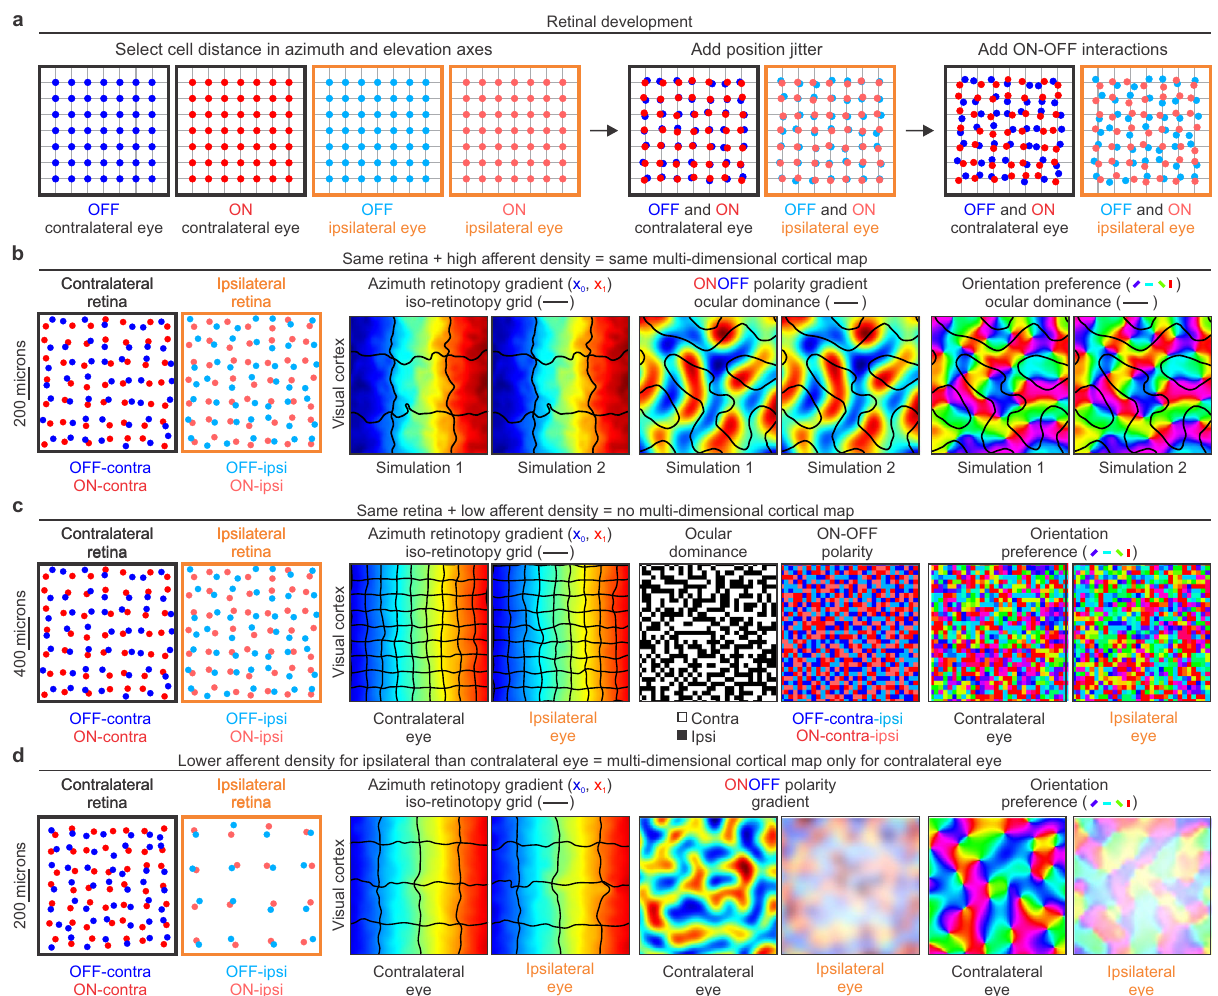
Fig. 3 First model stage: retinal development. a Mosaics of ON and OFF retinal ganglion cells from two eyes generated by the model. The model places cells of each type in a grid (left), then randomly jitters their retinal positions (middle), and applies cell interactions that prevent ON and OFF cells from occupying the same position in each eye. b If afferent sampling density is high, identical ONOFF retinal mosaics generate identical visual cortical maps as shown by two simulations (1 and 2) illustrated in each pair of panels. From left to right, simulated retinas for the two eyes and repeated simulated maps for retinotopy, ONOFF, and orientation preference of stimuli presented in the contralateral eye. The colors illustrate cortical gradients of azimuth retinotopy, ONOFF dominance and orientation preference. The black lines illustrate borders of iso-retinotopic cortical patches in the retinotopic map (regions containing cortical cells with overlapping receptive fi elds), and the ocular dominance borders in the ONOFF and orientation maps. c The same ONOFF retinal mosaics used in the simulations above ( b ) do not generate orientation maps if the spacing of retinal cells is increased to make the afferent sampling density lower (notice different retinal scale in b and c , 200 versus 400 microns). From left to right, each pair of panels show the two retinas, retinotopic maps for contralateral and ipsilateral eyes, afferents in the cortical subplate, and orientation maps. Notice that the size of the iso-retinotopic patch is smaller in ( c ) than ( b ) because the afferent sampling density is also lower. d If the afferent sampling density is lower for the ipsilateral than the contralateral eye, orientation maps emerge from afferent sorting only for the contralateral eye. From left to right, each pair of panels show the two retinas, retinotopic maps, ONOFF maps and orientation maps for the two eyes. Notice that the size of the iso-retinotopic patch is large for both eyes because there is a large number of afferents from the contralateral eye. The afferents from the ipsilateral eye are fewer in number and should have larger axon arbors because they have less synaptic Gaussians function (afferent sorting fi lter) with a cortical subplate with the same eye input and retinotopy (Fig. 4b) and, during the made of random binary values. The afferent sorting fi lter provides ONOFF sorting, they move to regions with the same retinotopy, a simple approach to adjust the shape and size of the afferent eye input and ON-OFF polarity (Fig. 4c, left). This simple clusters and iso-retinotopic domains based on visual sampling 29 algorithm is very effective at sorting afferents by type (Fig. 4c, (see Supplementary Fig 2). However, the model can use any other left). Moreover, because the sorted afferents have similar sorting fi lter that segregates afferents by retinotopy, eye input and retinotopy, the retinotopic map is preserved (Fig. 4c, right). ON-OFF polarity as long as the sorting maximizes the coverage of The theory predicts that visual retinotopic maps will not form all stimulus dimensions per visual point. if thalamic afferents are not sorted by retinotopy (Fig. 4d), ocular The only role of the afferent sorting fi lter is to fi nd the best dominance maps will not form if afferents are not sorted by eye local movement of an afferent to join afferents of the same type input (Fig. 4e), and ON-OFF maps will not form if afferents are (Fig. 4a). During the ocular sorting, afferents move to regions not sorted by ON-OFF polarity (Fig. 4f). In addition, the theory